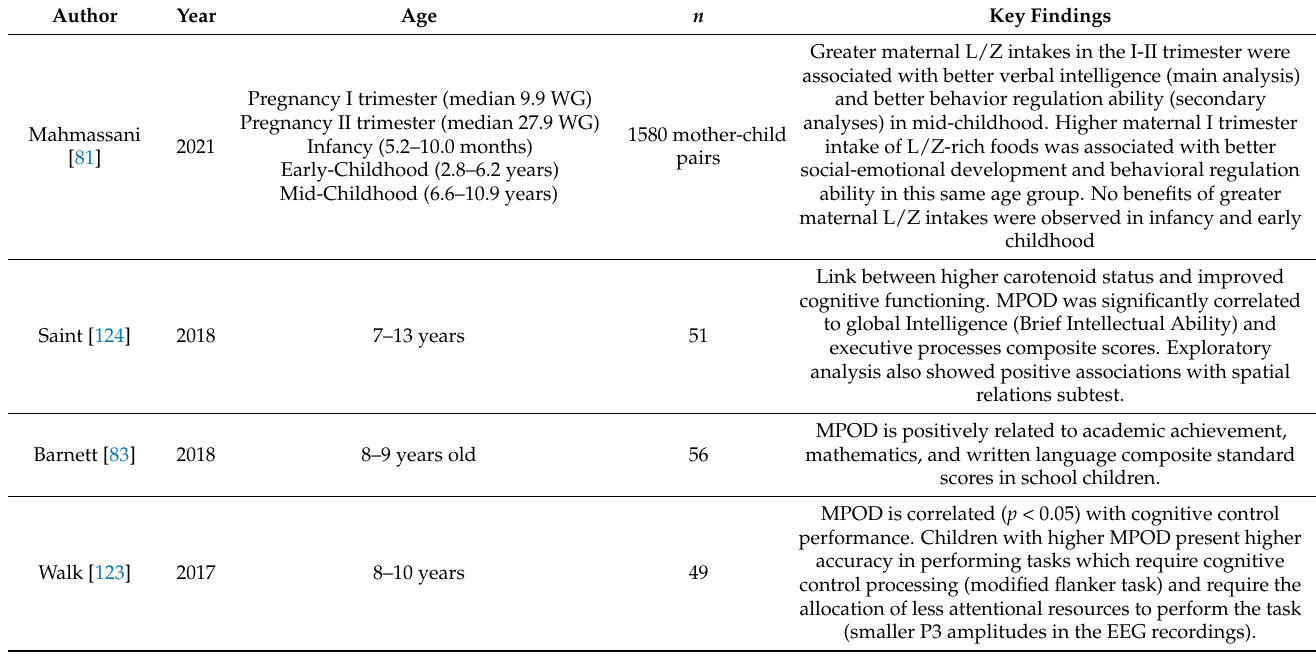
Table 3. Observational studies addressing the relationship between lutein and zeaxanthin status and cognitive function in a pediatric